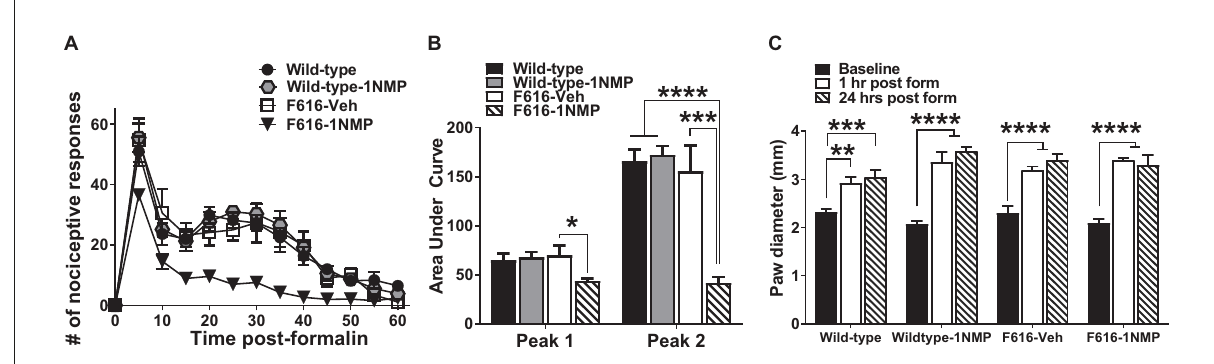
FIGURE1 Inhibition of TrkB attenuates formalin-induced inflammatory pain responses. (A) Intraplantar administration of formalin induced a biphasic nociceptive response characterized as phase 1 (0–10 min) and phase 2 (11–60 min) in three (Wild-type, Wild-type-1NMP and F616-Veh) of the four experimental groups of mice. There were no differences in cumulative number of responses between Wild-type, Wild-type-1NMP, and vehicle-treated F616 mice except at 60 min, where Wild-type was different to F616-Veh ( p = 0.02). The number of responses in 1NMP-treated F616 mice was significantly reduced compared to wild-type and F616-Veh mice at binned times ranging from 15 to 50 min and from wild-type- 1NMP at 5–55 min (p values ranging from p < 0.05 to p < 0.0001; 2-way ANOVA with Tukey’s multiple comparisons tests). (B) Quantitative measurement of the formalin response (area under the curve; AUC) revealed that F616–1NMP mice had a significantly reduced phase 1 response compared to F616-Veh treated mice only ( p < 0.05), while their phase 2 response was robustly decreased compared to both wild-type groups ( p < 0.0001) and F616-Veh group ( p < 0.001). (C) Formalin induced significant paw edema in all four treatment groups, which was evident at both 1 and 24 h post-formalin (* p < 0.05; ** p < 0.01; *** p < 0.001; and **** p <